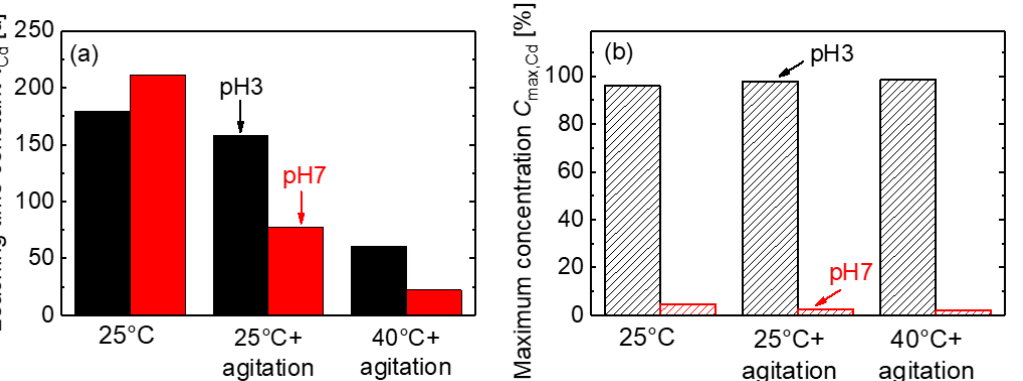
Figure 13. Calculated fit parameters for the leaching of Cd from CdTe module pieces under different conditions. ( a ) Leaching time constant τ Cd for solutions with pH 3 and pH 7. ( b ) Maximum concentration C max for the same conditions as in ( a